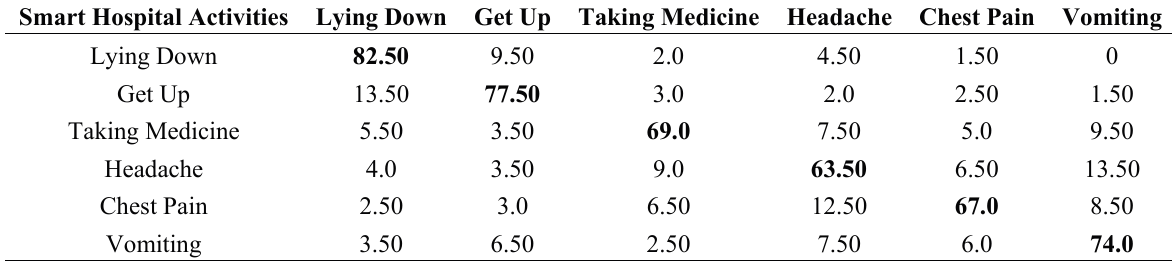
Table 9. Confusion matrix based on recognition results of smart hospital activities using PC features of depth silhouettes.